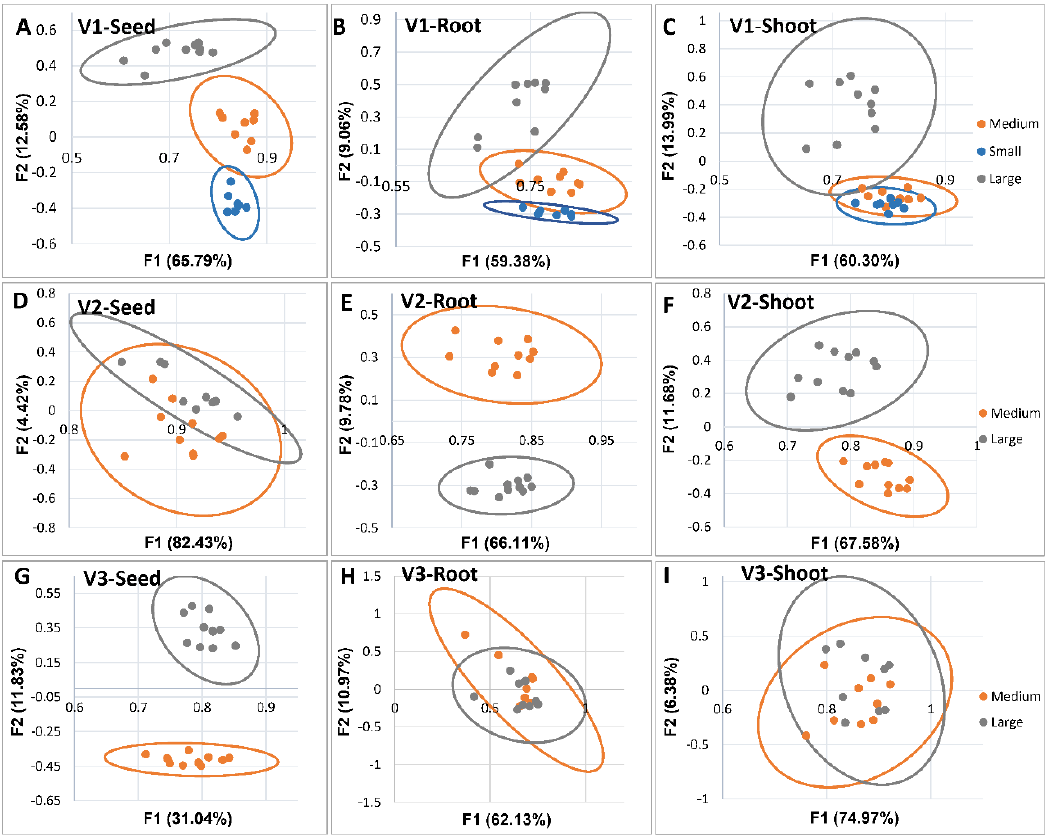
Figure 4. PCA biplots of seed, root, and shoot microbiome of three hybrid corn varieties. Each plot compares the microbial profiles of di ff erent seed categories (small, medium, and large) within each tissue type in every variety. V1-Seed ( A ), V1-Root ( B ), V1-Shoot ( C ), V2-Seed ( D ), V2-Root ( E ), V2-Shoot ( F ), V3-Seed ( G ), V3-Root ( H ), and V3-Shoot ( I ). Nonoverlapping circles are statistically significant at 95% confidence level ( p < 0.05) according to Bartlett’s sphericity test. Further the distance (between circles) goes, the stronger the difference become among the communities.